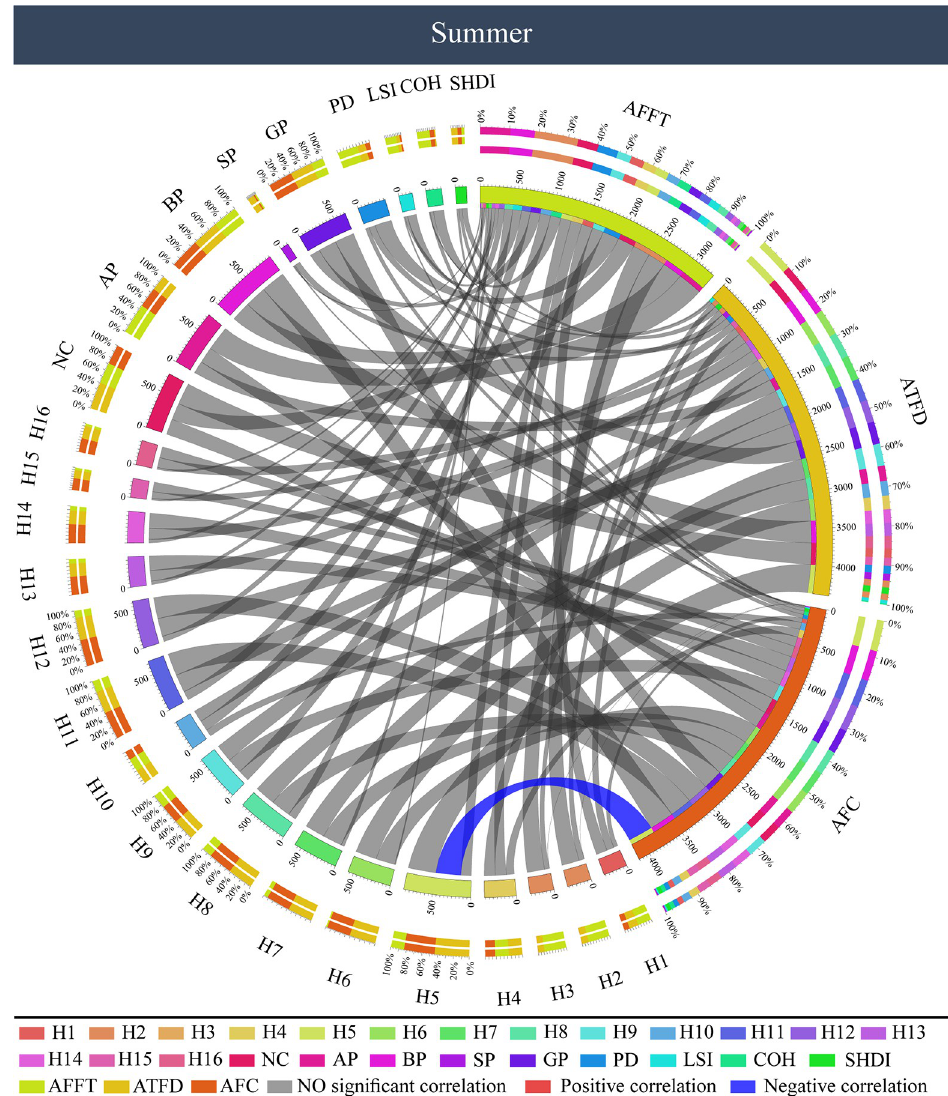
Fig 7. Correlation between color characteristics and visual behavior of forest color pictures in summer. AFFT: AOI first fixation time, ATFD: AOI total fixation duration, AFC: AOI fixation count.